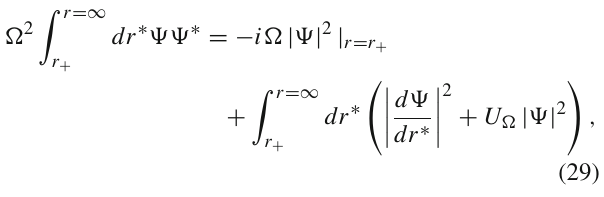
< μ 2 μ 2 at r = r + is plotted in the upper left panel of ef f BF − μ 2 ) Q 2 | Fig. 1. The distribution of values of (μ 2 r = r + ef f BF is also displayed, which shows that the tachyonic instabil- ity region becomes larger as α increases, and the scalar field suffers from a strong tachyonic instability when black holes are near-extremal. The bifurcation line is composed of the l = 0 = n zero modes of Eq. (23) for the scalar perturbation in RNAdS black holes, and represented by blue dashed lines in Fig. 1. When the tachyonic instability is strong enough, the scalar perturbation can lead to scalarized black holes with non-trivial scalar fields above the bifurcation line. In the upper right panel of Fig. 1, we display the domain of existence for scalarized black holes, which is exhibited by a light blue region. The domain of existence is bounded by the bifurcation and critical lines, and resembles that of RN scalarized black holes [24] . On the critical line, the mass and the charge of scalarized solutions remain finite, whereas its horizon radius vanishes. On the other hand, the mass-to- charge ratio q of RNAdS black holes reaches the maximum value in the extremal limit, which is shown by a horizontal dashed gray line. Moreover, there is a certain region bounded by the extremal and bifurcation lines, where scalarized and RNAdS black holes coexist.